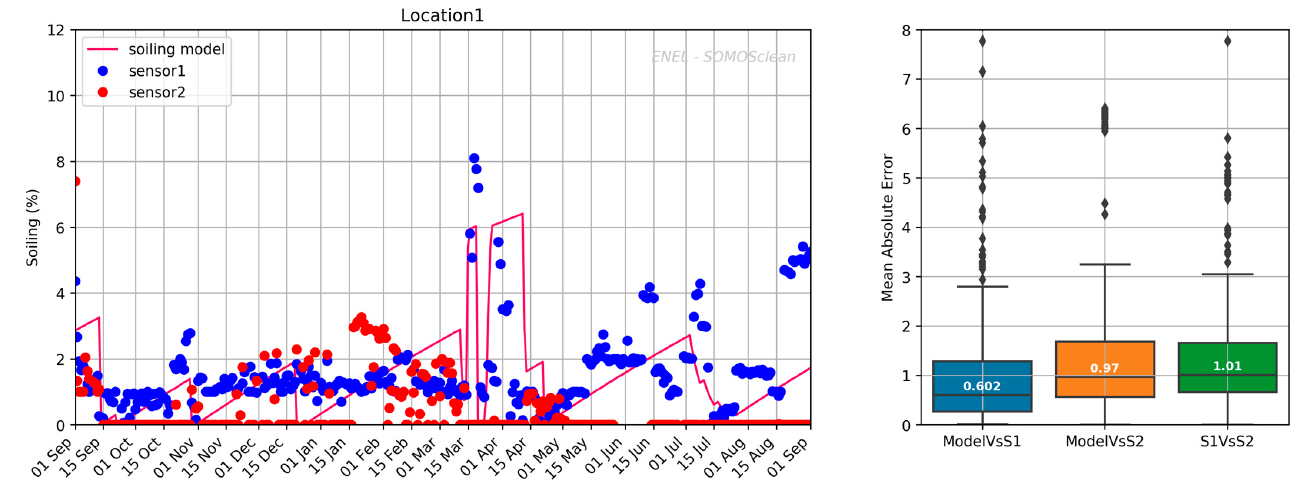
Figure A1. Soiling data from the power plant at location 1.